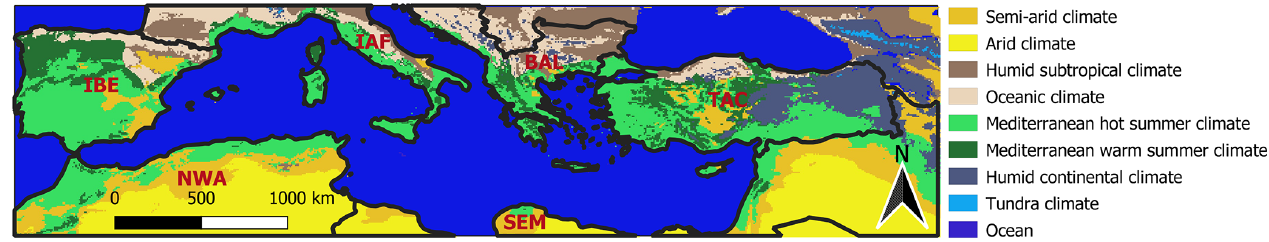
Figure 1. Study area in the Mediterranean Basin: the Köppen–Geiger climate categories “Mediterranean hot summer climate” (light green) and “Mediterranean warm summer climate” (dark green) are included in this study. The study area was divided into six subregions: the Iberian Peninsula (IBE), Italy and France (IAF), the Balkan Peninsula (BAL), Turkey and Cyprus (TAC), the south-eastern Mediterranean (SEM), and north-western Africa (NWA)